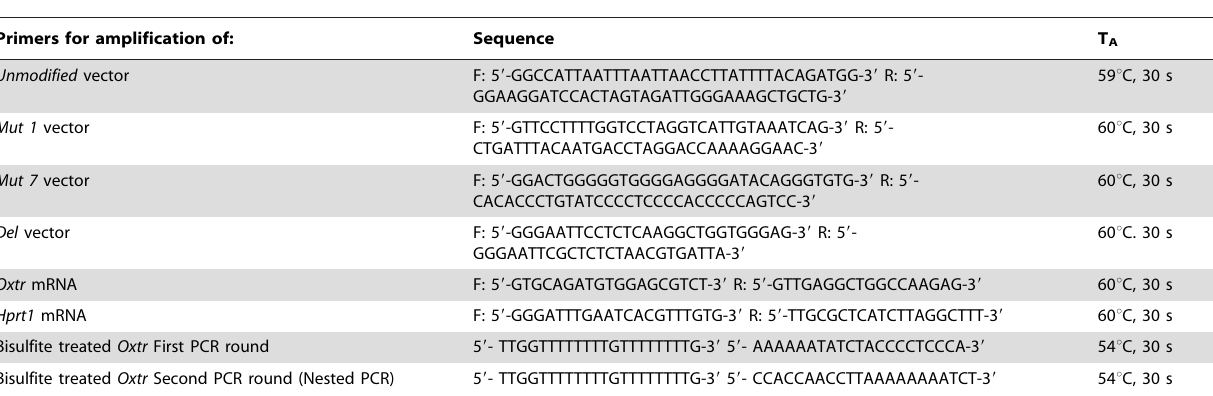
Table 1. PCR primer